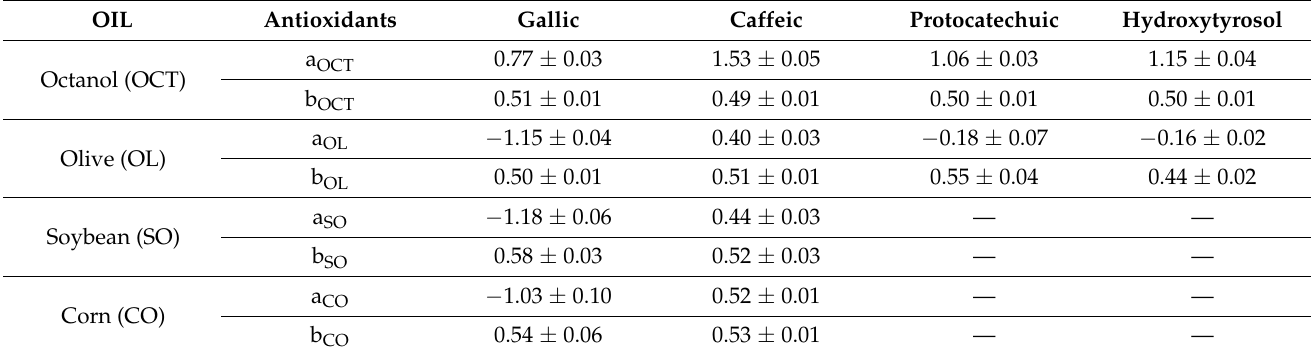
Table 5. Slopes and intercepts for the variations of log( P WO ) with the number of methylene groups according to Equation (5) (Figure 3) for ester derivatives of different antioxidants such as gallic acid (GA), caffeic acid (CA), protocatechuic acid (PT), and hydroxytyrosol (HT). Values from Freir í a- G á ndara et al.